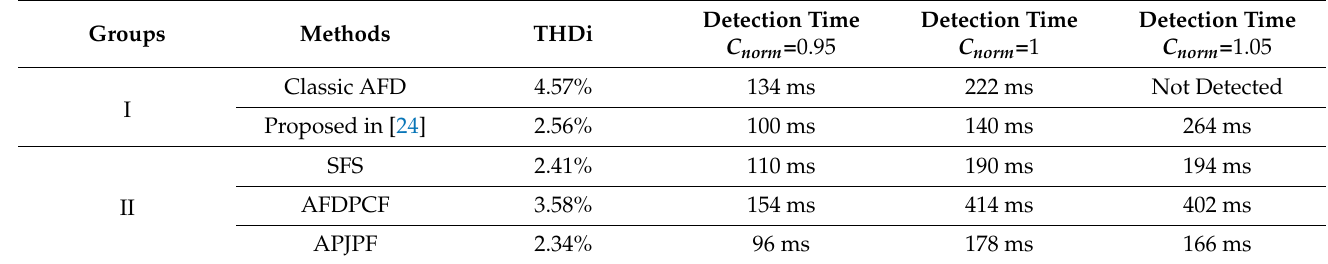
Table 4. Synthesis of the main experimental results of the analyzed AIP methods.